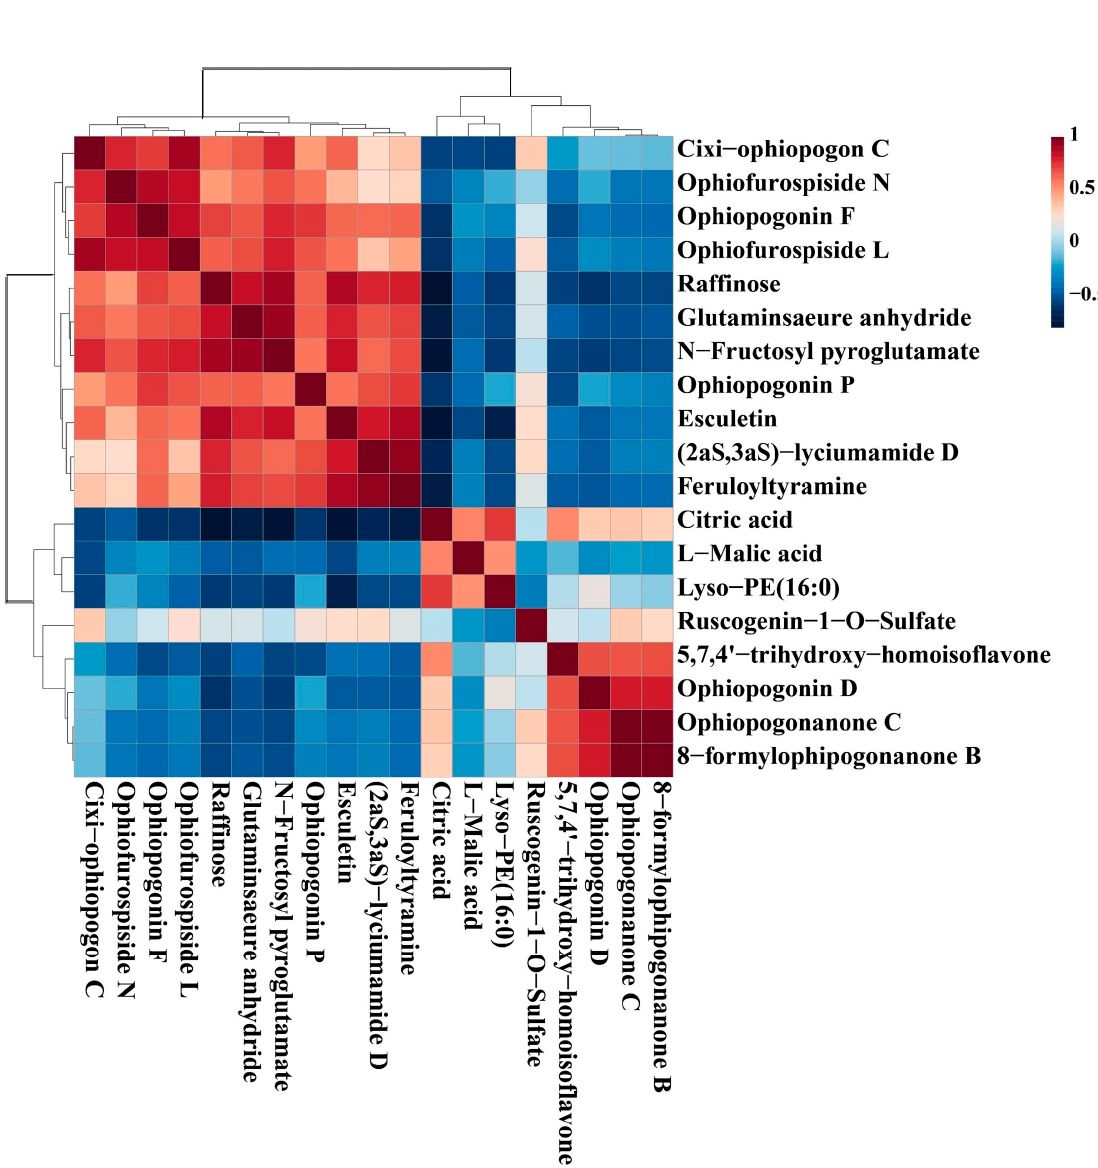
Figure 9. The correlation analysis of potential markers of MD with different levels of SF.